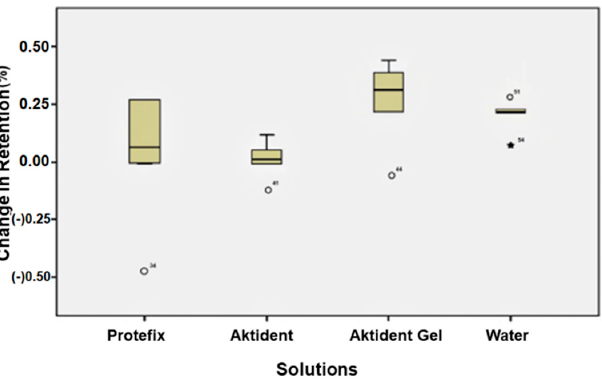
Figure 4. Percent change in retention values for green attachments after immersion in different cleansing solutions .